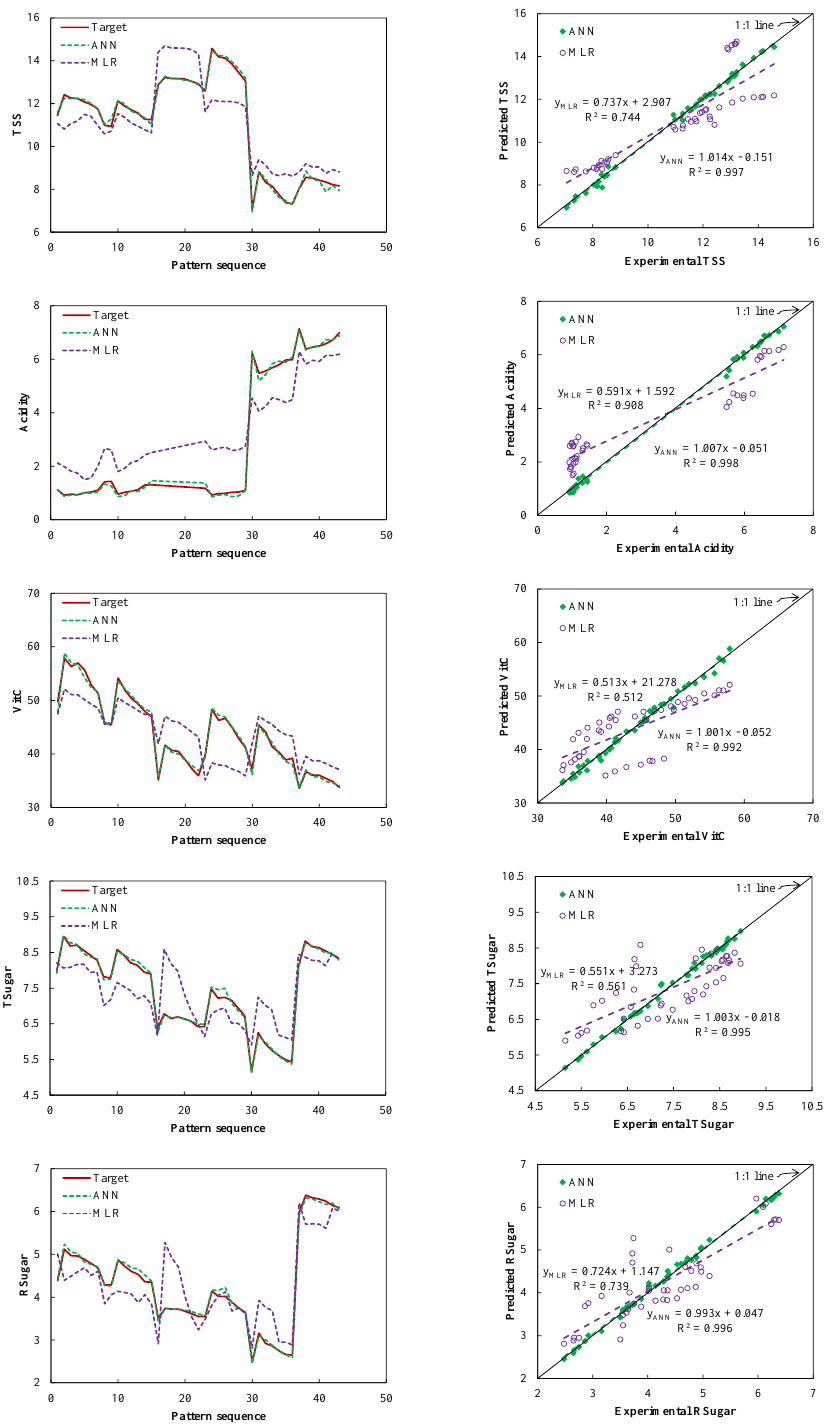
Figure 5. Comparison between experimental and predicted values of total soluble solids (TSS), acidity, vitamin C (VitC), total sugars (Tsugar), and reducing sugars (Rsugar) using ANN and MLR models during the testing process.